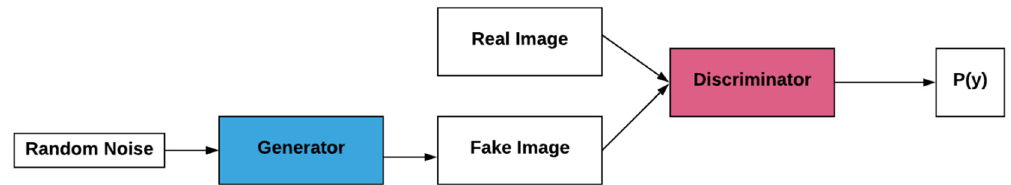
Figure 3. A standard GAN framework, consisting of a generated which generates fake images from a random probability distribution, and a discriminator, which learns to discriminate between real and fake images.